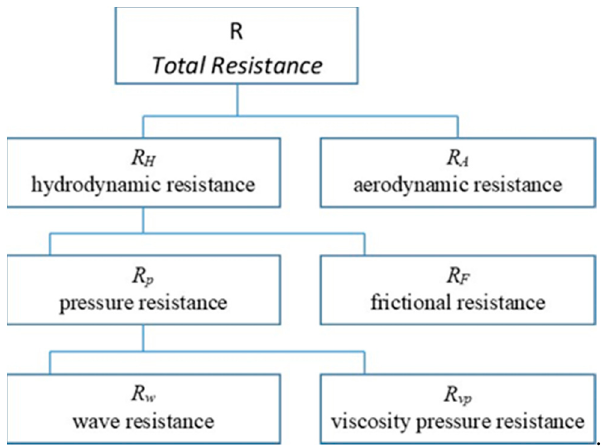
Figure 2. The total hull resistance structure [13].